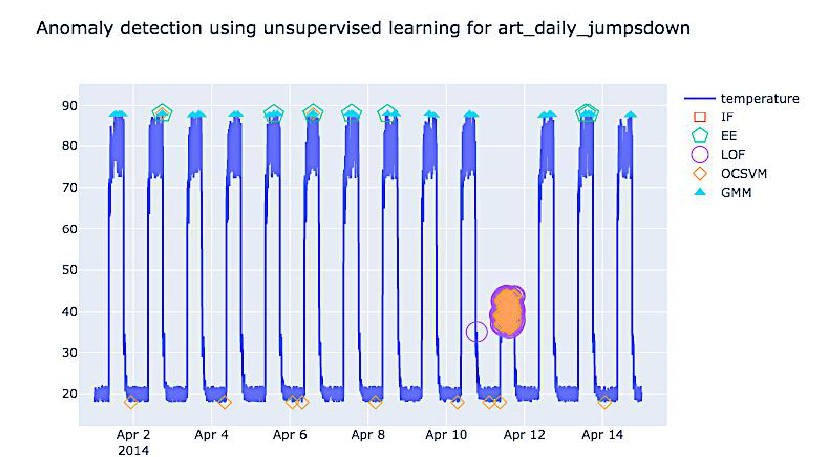
Figure 15. Visualization of novelty anomaly detection using trained unsupervised learning model for jumps down in art daily dataset from